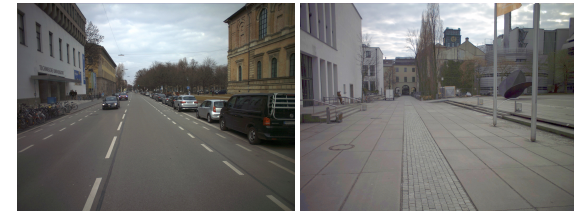
Figure 4. Examples of images recorded with MMS front cameras